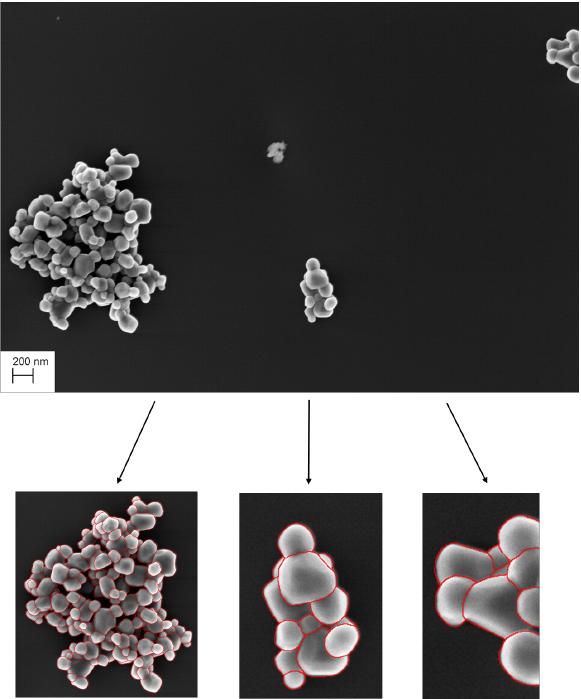
Figure 2. Measured SEM image ( up figure ) and its annotated agglomerates ( down figures